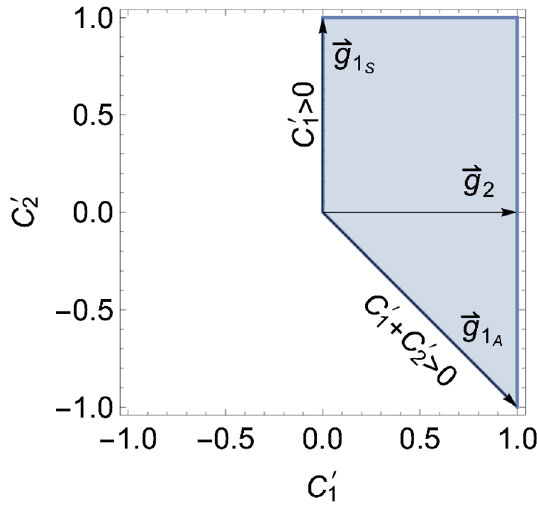
Figure 3. Positivity cone for an EFT with 2-scalars under SO(2) . The arrows represent the generator